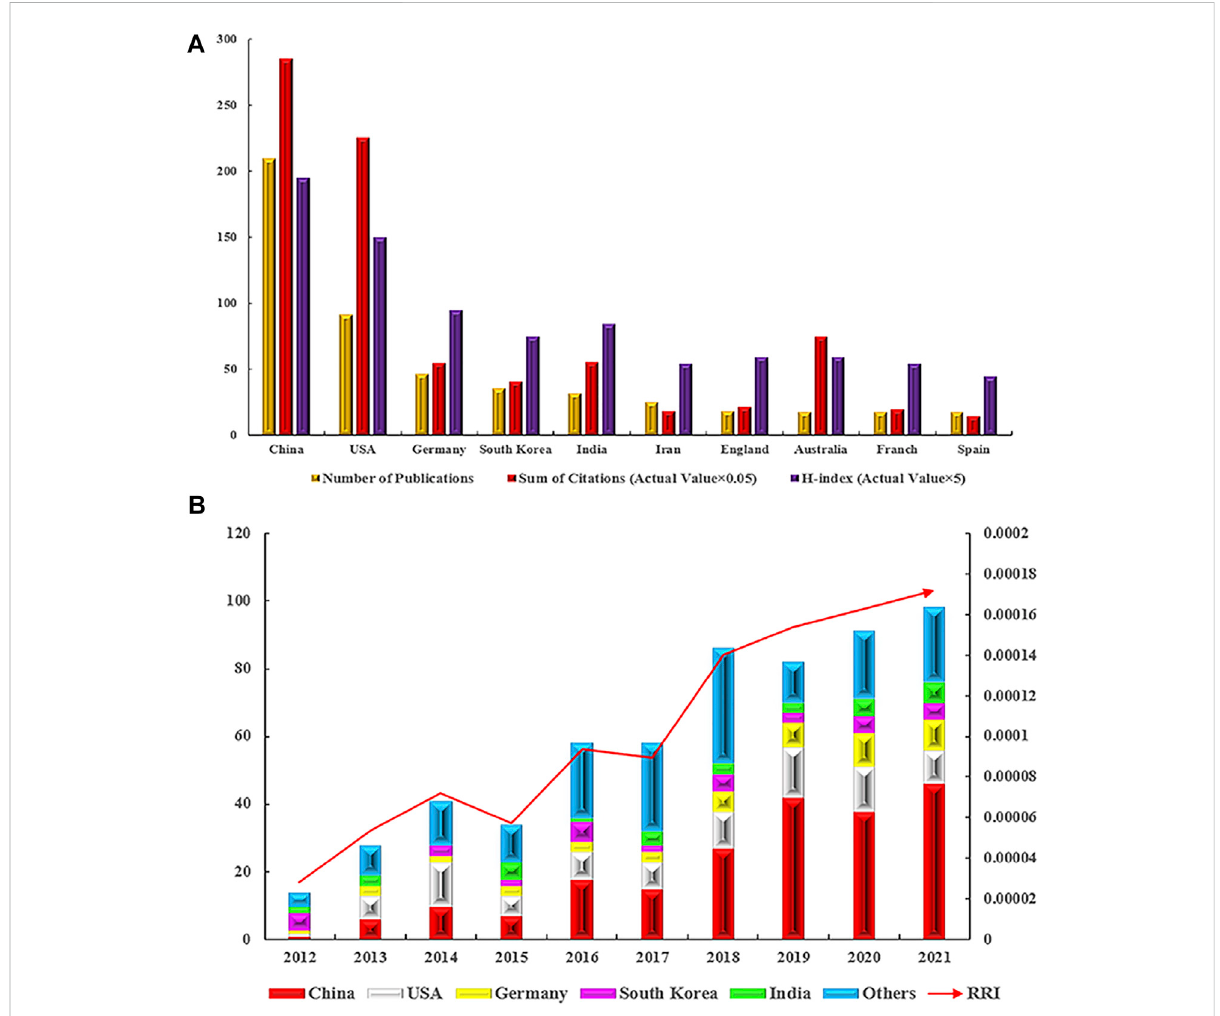
FIGURE 3 Contributions of different countries/regions to theresearch on metal materials and bone repair. (A) Number of publications, citation frequency (×0.05), and H-index (×5) in the top 10 countries or regions (B) number of publications worldwide and the time course of the RRI in metal materials and bone